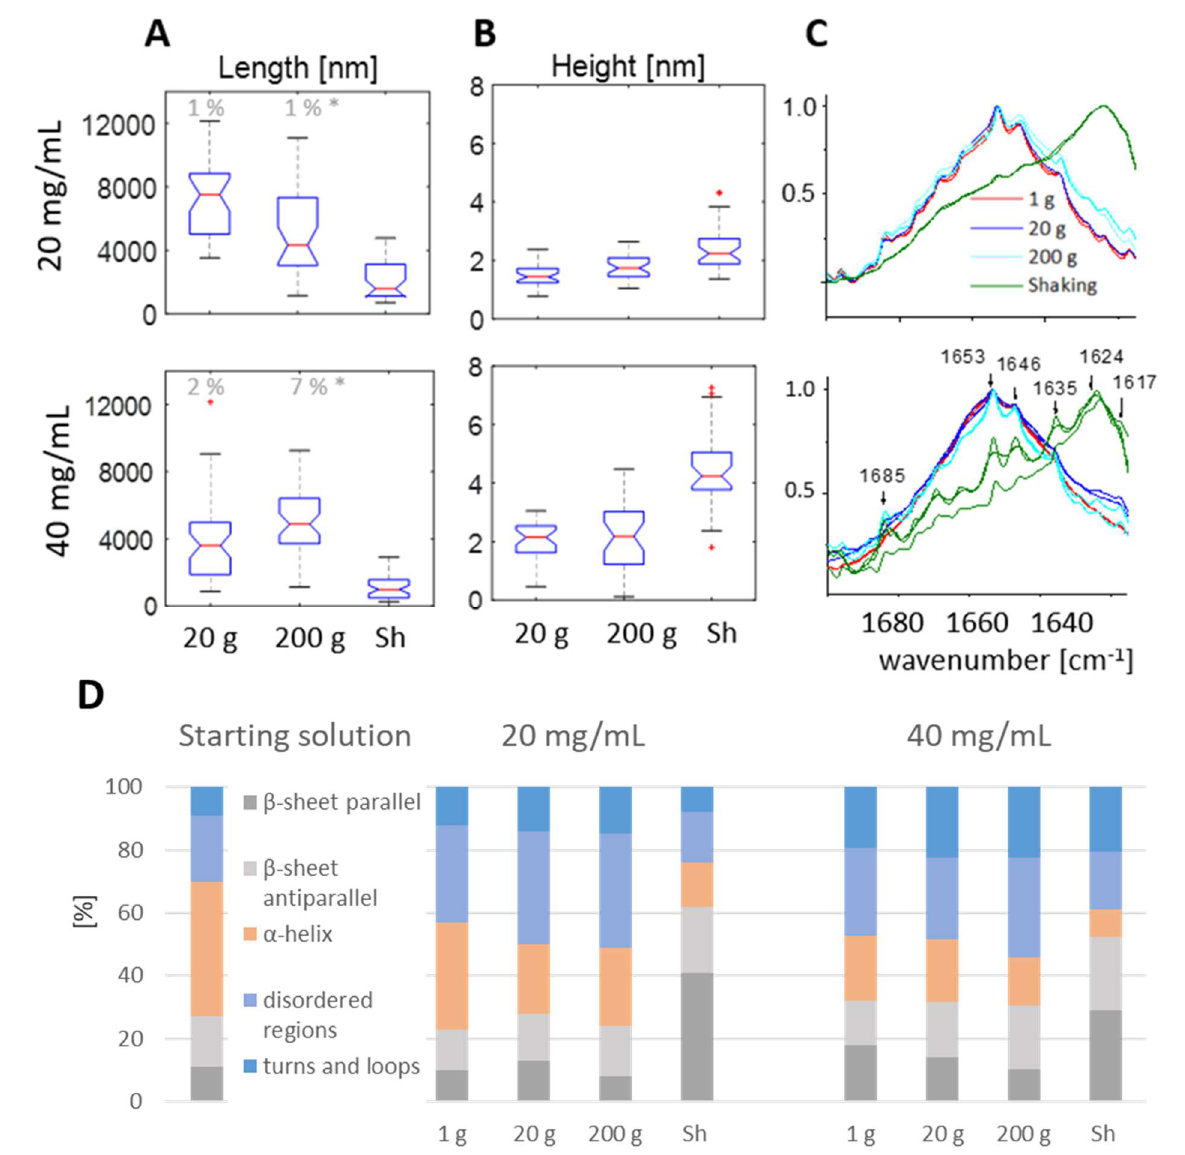
Figure 3. ( A ) Boxplots presenting the comparison of lengths and ( B ) heights of fibrils formed in the three studied agitation conditions (centrifugation at 20 × g , 200 × g, and shaking) for two lysozyme concentrations. Each boxplot summarizes 35 measurements. Red crosses indicate outliers, e.g., data points larger or smaller than 1.5 times the interquartile range below or above the first quartile or third quartile, respectively. The percentage of fibrils on the image that is not fully fitting the image but has a visible length longer than 6 µ m is indicated on top of the boxplot; ( C ) overlap of normalized IR spectra for each condition, ( D ) percentage of secondary structures in different fibrilization mixtures for two lysozyme concentrations compared to the initial solution immediately after adaptation to 2 at 42 ◦ C. Lysozyme samples were prepared at pH 1.5 with 15% EtOH and studied after 2 weeks of appropriate agitation at 42 ◦